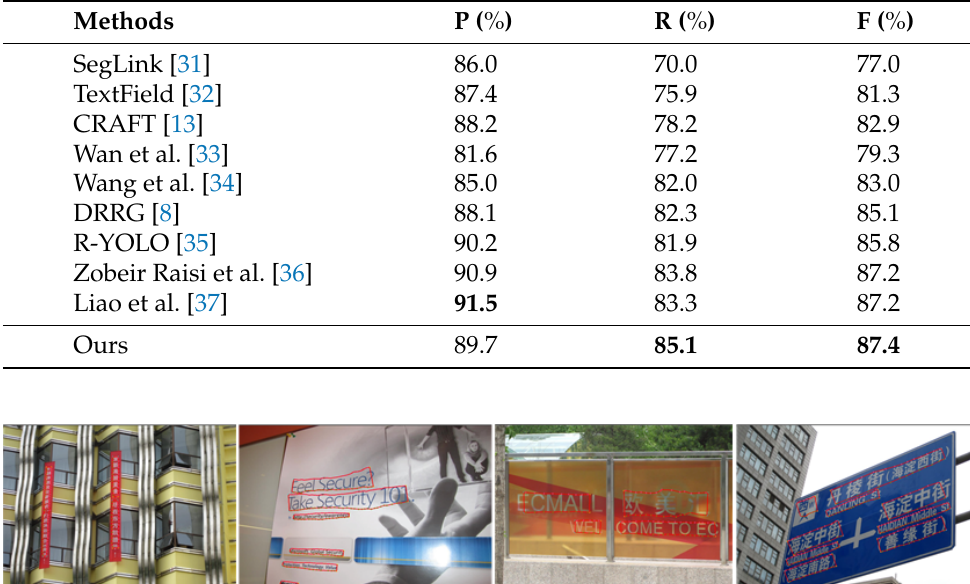
Figure 8. Detection examples of the proposed method in the ICDAR2013 dataset. Table 4. Experimental results of various methods on the MSRA-TD500 dataset.